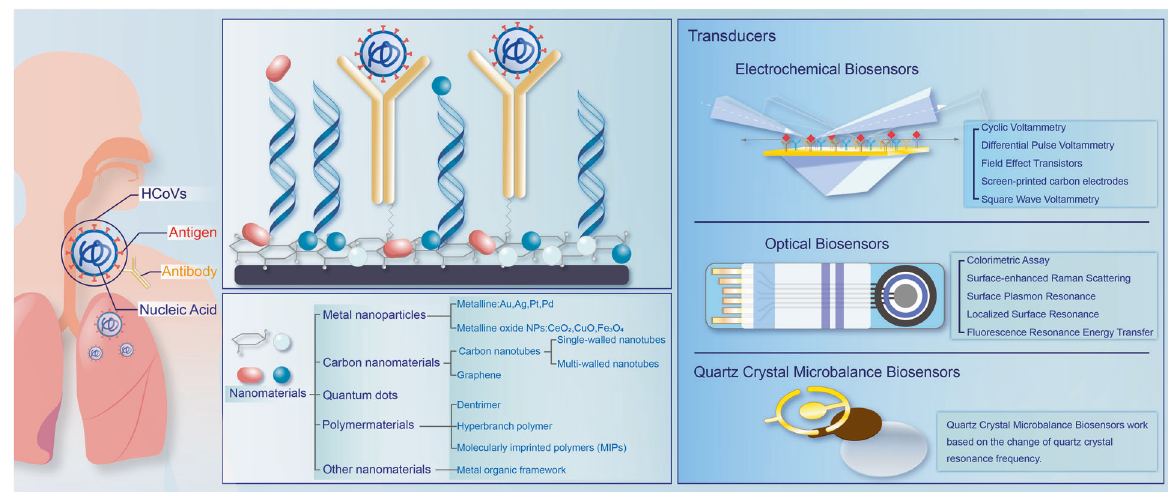
Fig. 3 A scheme of several nanobiosensors for the detection of HCoVs. The detection target contains nucleic acids, antigens and antibodies. In biosensors, nanomaterials, such as metal nanoparticles, carbon nanomaterials, quantum dots, polymer materials, and others are utilized. The transducers, including electrochemical biosensors, optical and quartz crystal microbalance sensors, transduced the reaction of receptor and target to electrical, visible, and other measurable